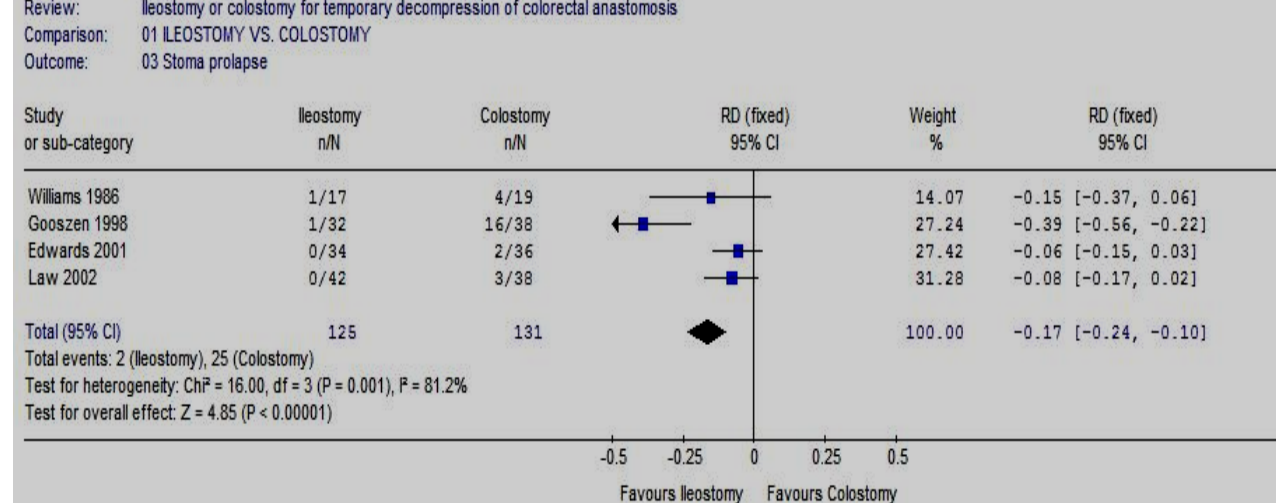
FIGURE 3 – Graph for the outcome of stoma prolapse